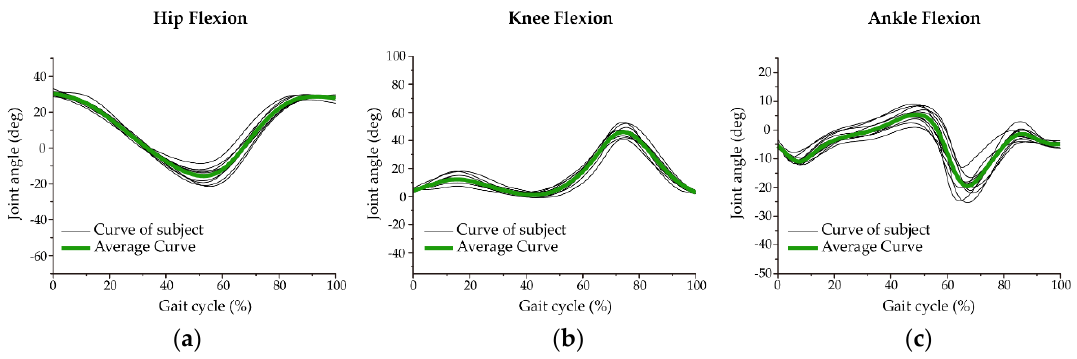
Figure 4. The curves of participants and their average curves of three lower joints in normal ranges: ( a ) Ten angle curves (black line) and the average curve (dark green line) from the hip joint in one gait cycle; ( b ) The curves of knee flexion; ( c ) The ankle joint curves.